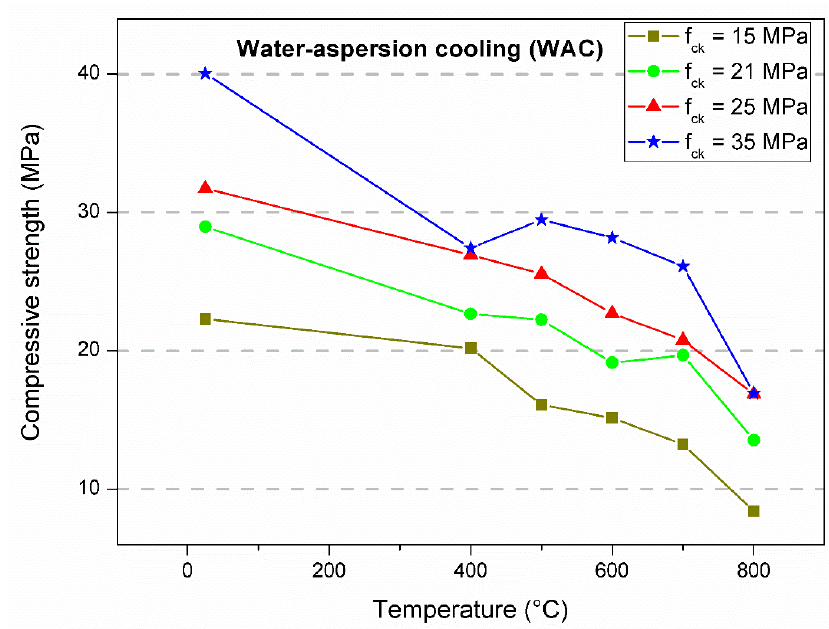
Figure 4. Compressive strength average of specimens tested when hot.